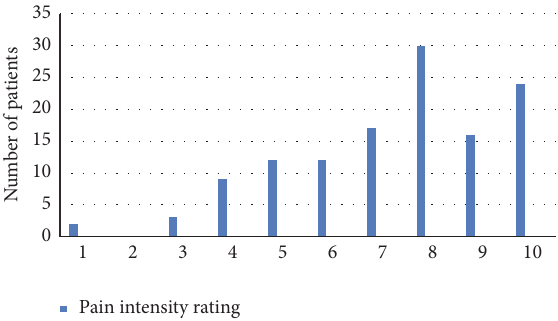
Figure 2: Pain levels with episodes of severe exacerbations.